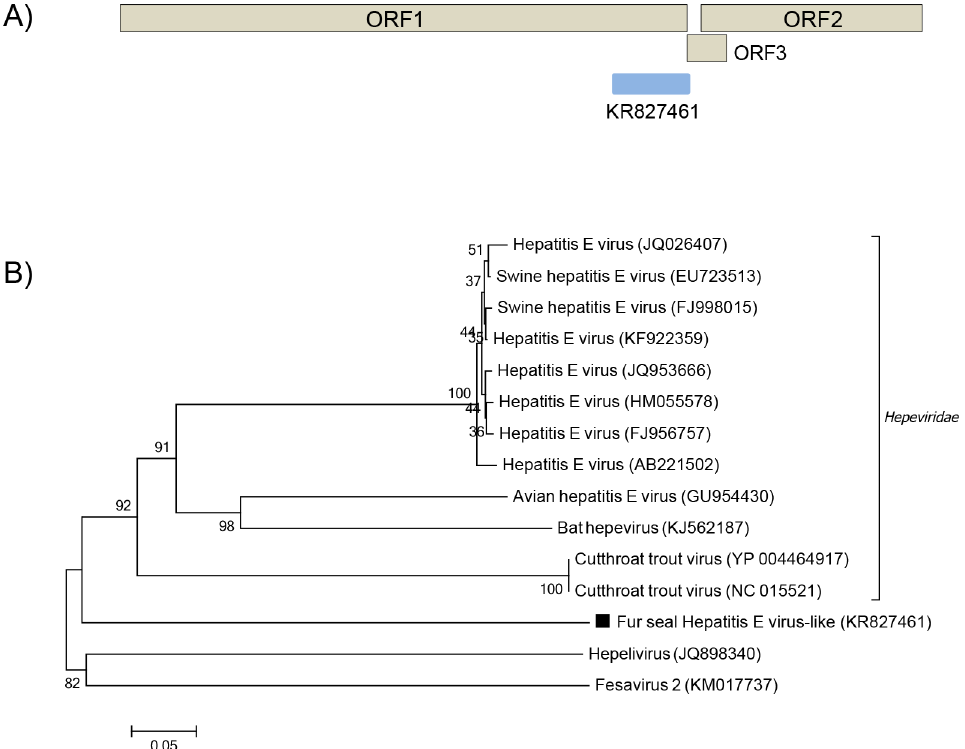
Fig 9. Phylogenetic analysis of fur seal hepevirus-like. (A) Schematic representation of the genome of hepeviruses using as an example the hepatitis E virus (~7.2 kb). The blue bar represents the contig from South American fur seal. (B) Neighbor-joining phylogenetic tree based on the alignment of partial amino acid sequences (182 aa) from the polyprotein of 15 hepeviruses. Hepelivirus and Fesavirus 2 were used as outgroup. The hepevirus-like virus sequence from South American fur seal identified in this study is labeled with a black square. The GenBank accession numbers of the viral sequences are shown in